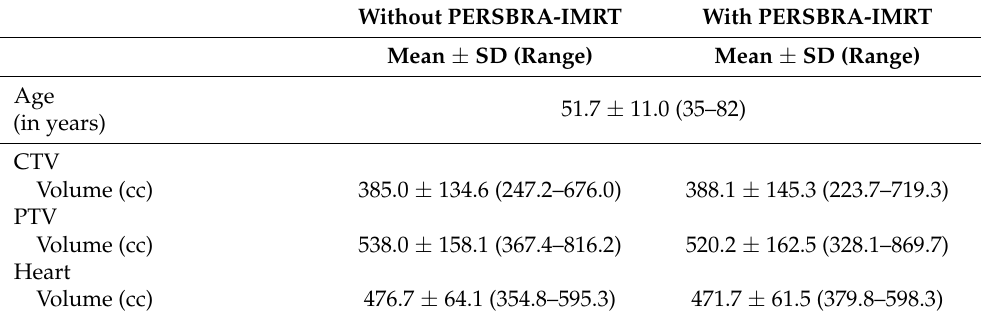
Table 1. Patients’ characteristics.